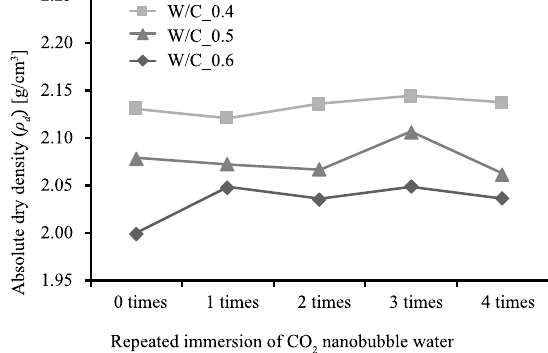
Figure 3. Relationship between number of immersions and absolute dry density.